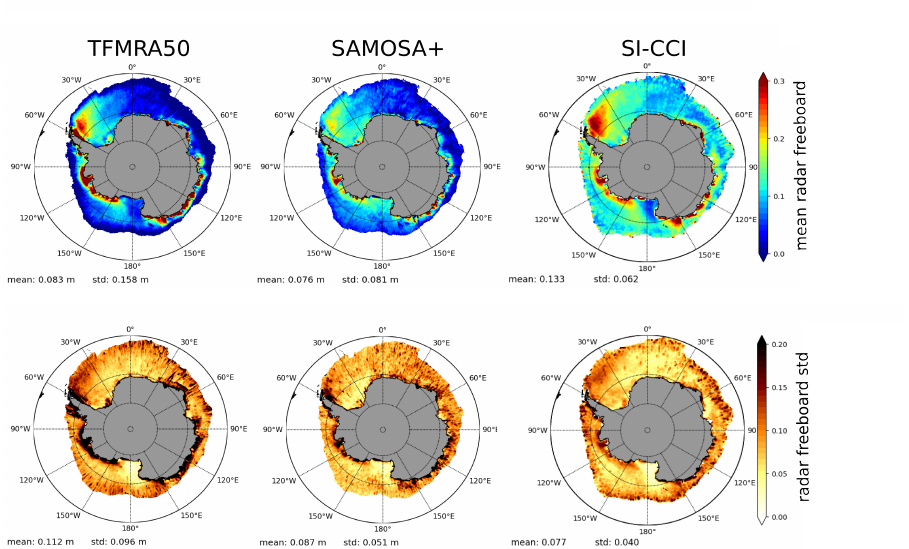
Figure 1. Maps of the climatological mean and standard deviation (Sd) of CryoSat-2 radar freeboards computed from the TFMRA-50 (CS2-TFMRA50, first column) and SAMOSA+ (CS2-S+, second column) retrackers over 2011–2020. They are compared with the climatological mean and standard deviation of the SI-CCI CryoSat-2 radar freeboard dataset (third column), computed over 2011–2016. Note that the climatological mean and standard deviation are calculated at each grid point using all the available monthly radar freeboard mean maps over